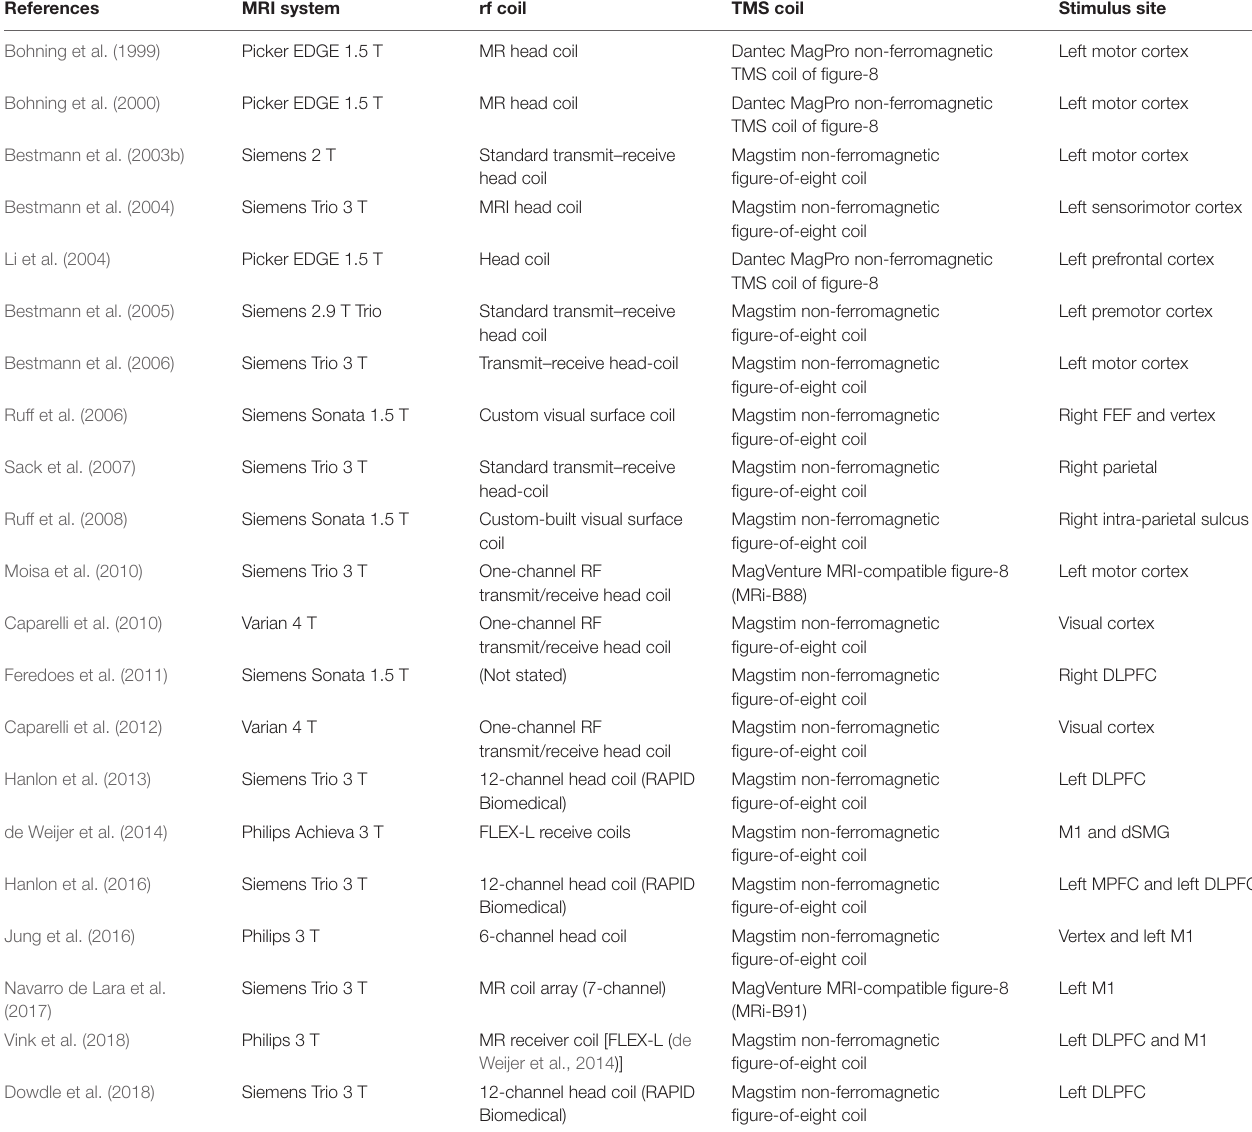
TABLE 1 | A summary listing some of the previous TMS-fMRI